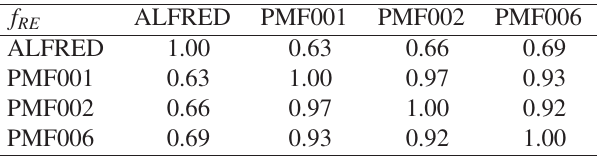
Figure 1. ALFRED core model. Table 3. k ef f uncertainty quantification for ALFRED with JENDL-4.0u2. Table 1. k ef f uncertainty quantification for ALFRED with JEFF-3.3.